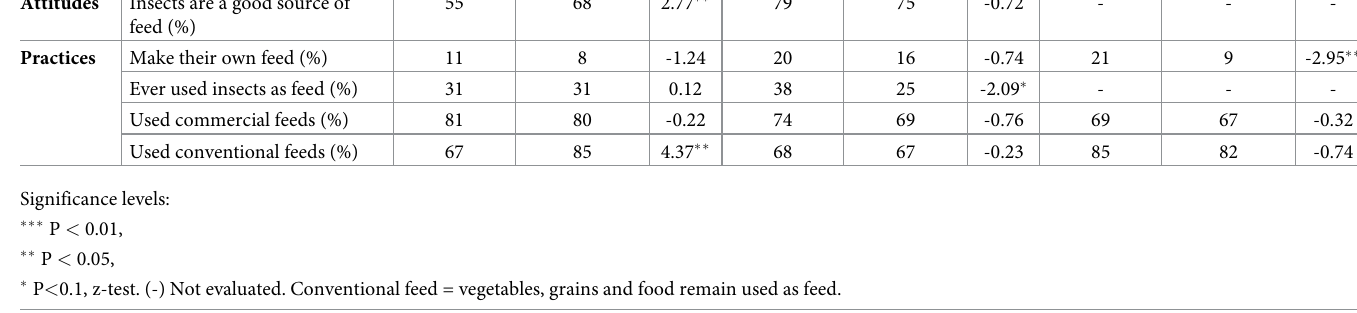
Knowledge Aware that insects can be used as feed